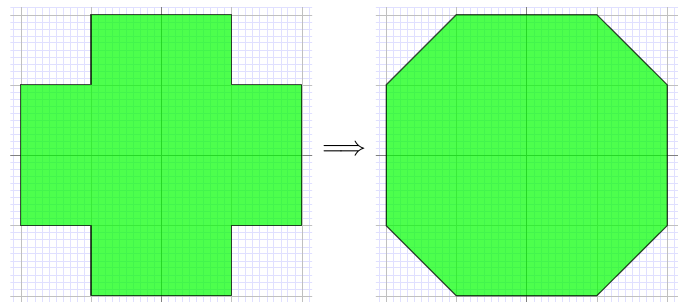
. Right: domain X 000 2